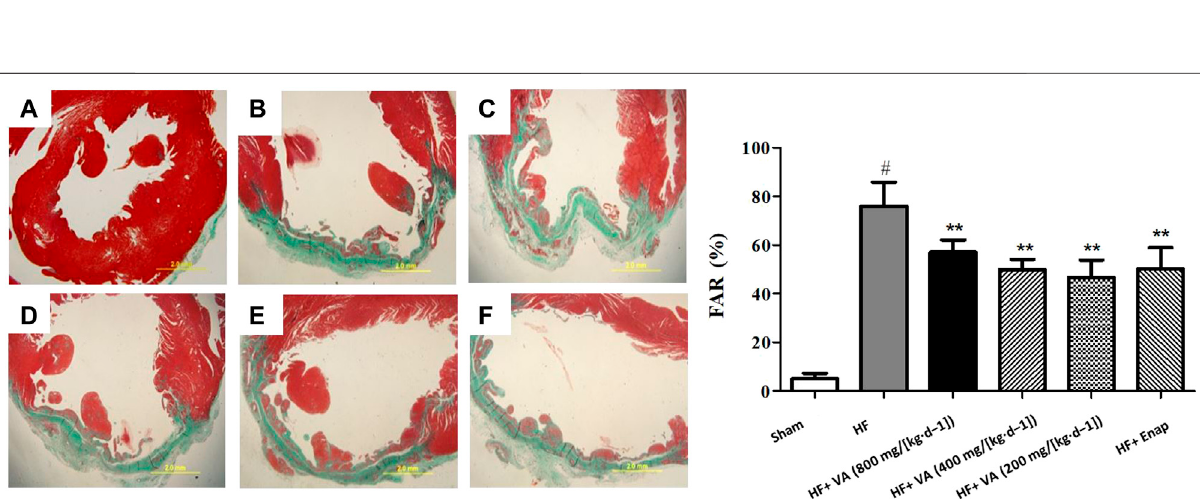
Frontiers in Pharmacology |